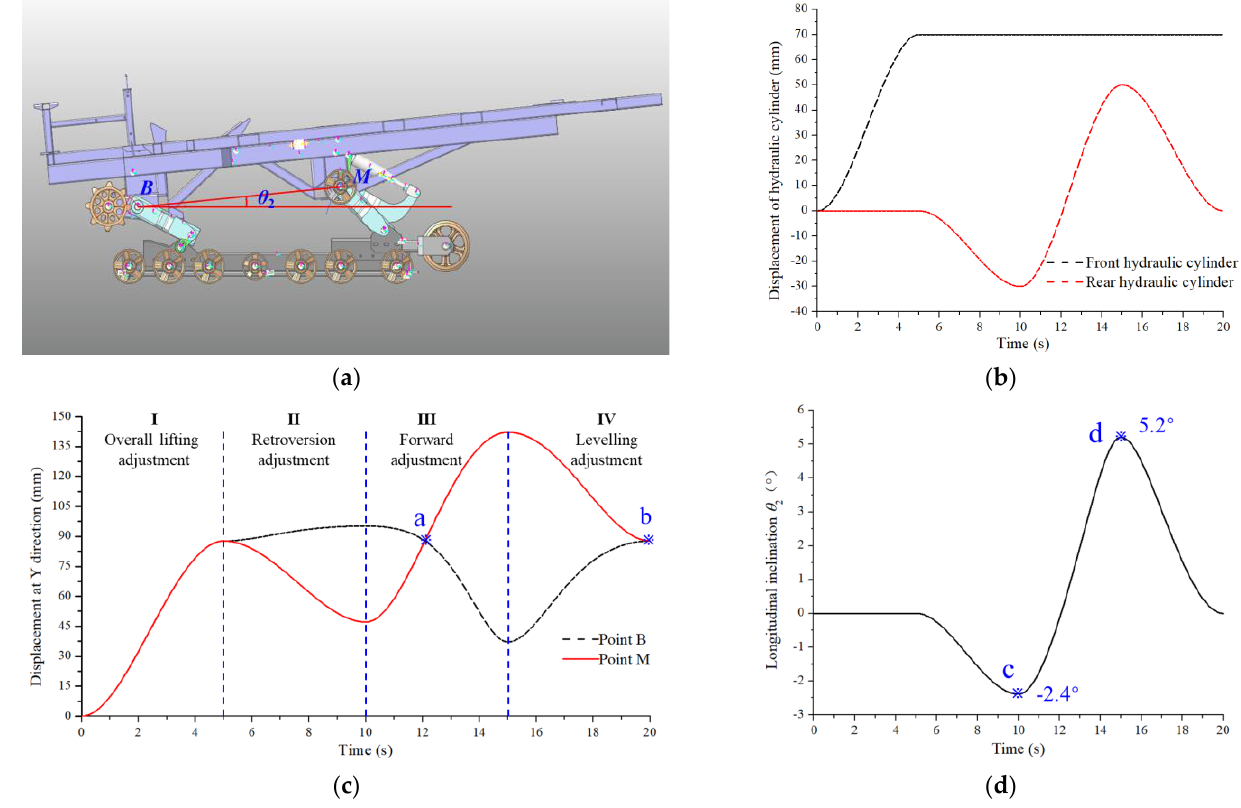
Figure 9. Simulation results of overall lifting adjustment and longitudinal tilting adjustment: ( a ) Forward inclination in the simulation environment. ( b ) Hydraulic cylinder displacement. ( c ) Displacement curve of the hinge point in the Y-direction. ( d ) Change curve of longitudinal inclination angle θ 2 . Position a: within 10 – 15 s, the chassis reached the horizontal position; Position b: within 15 – 20 s, the chassis reached the horizontal position again; Position c: at the 10 s, the chassis reached the maximum tilting adjustment angle – 2.4°; Position d: at the 15 s, the chassis reached the maximum forward inclination adjustment 5.2°.